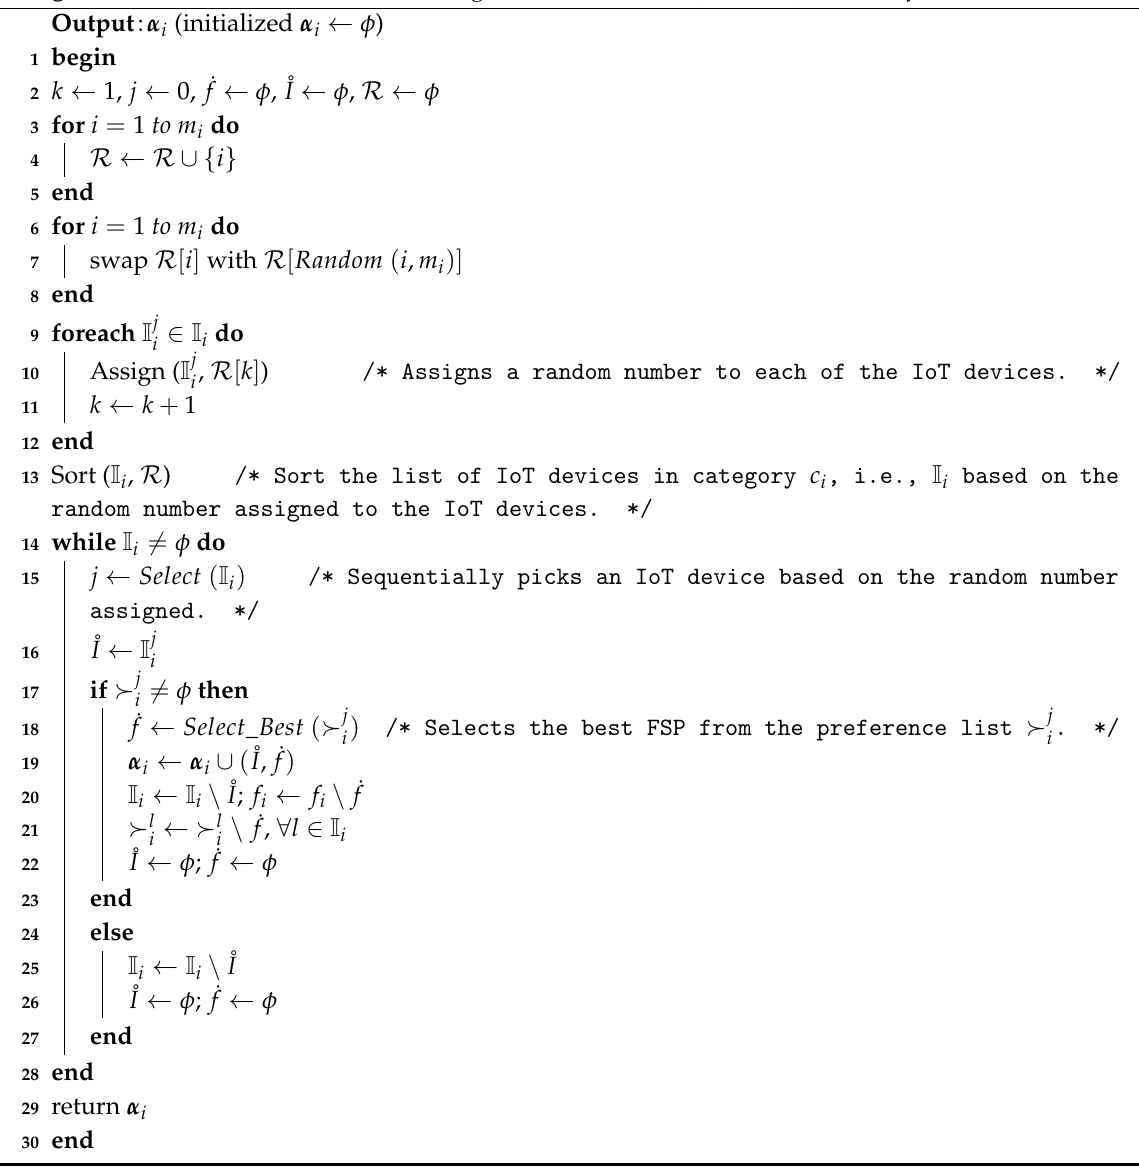
Algorithm 4: Truthful Mechanism for Fog Service Allocation (TM-FSA) routine ( f i , I i ,